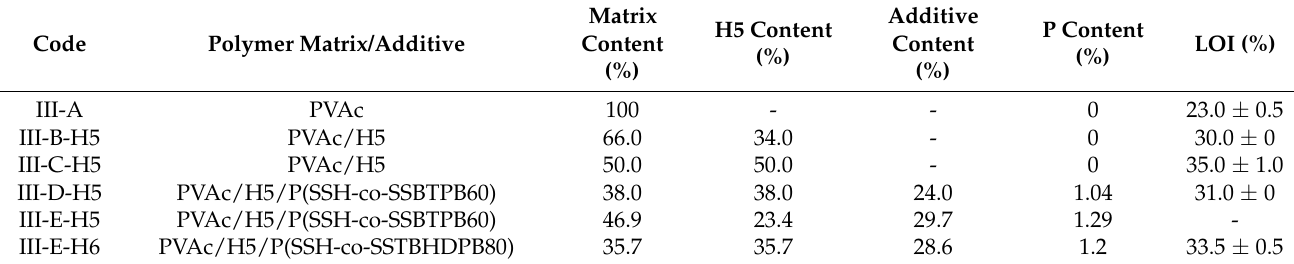
Table 7. LOI measurements of PVAc blends with H5 and additives.